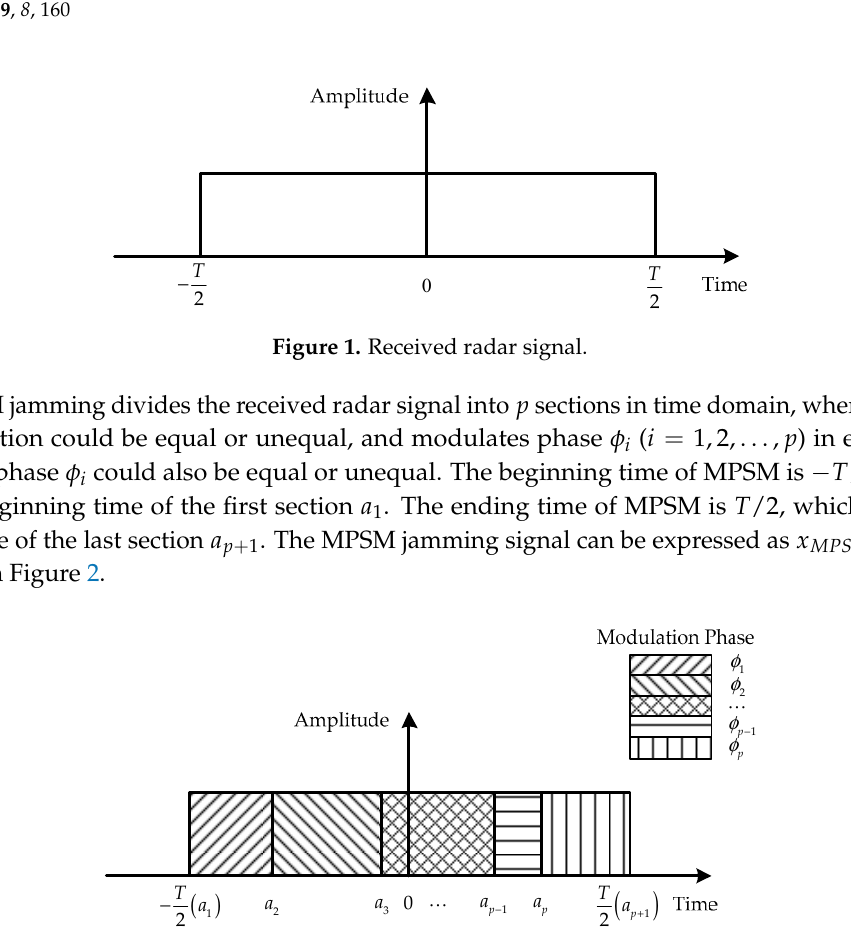
Figure 2. Received radar signal after multiple phases sectionalized modulation (MPSM).